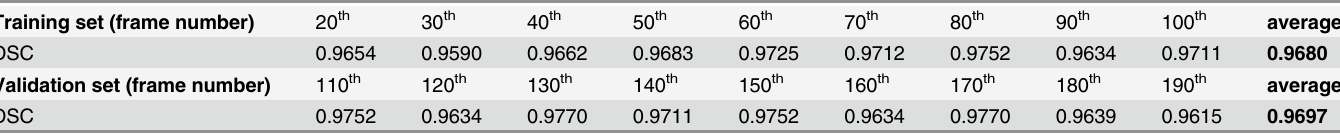
Table 4. DSC Values of Training Set and Validation